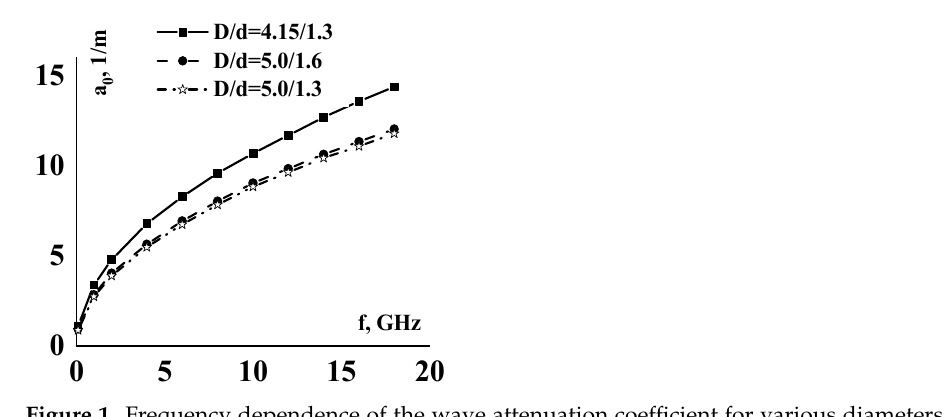
Figure 1. Frequency dependence of the wave attenuation coefficient for various diameters of the outer and inner conductors of the coaxial line.